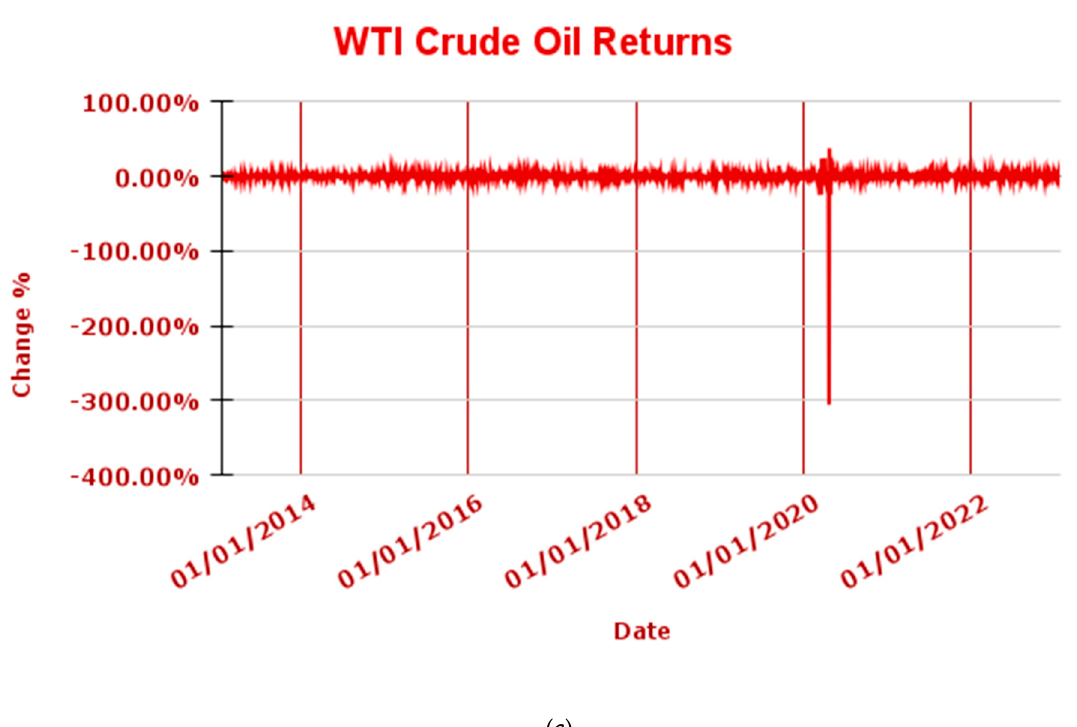
Figure 1. Shows the daily returns of ( a ) Nickel, ( b ) Cobalt and ( c ) WTI Crude Oil for the Period under study.